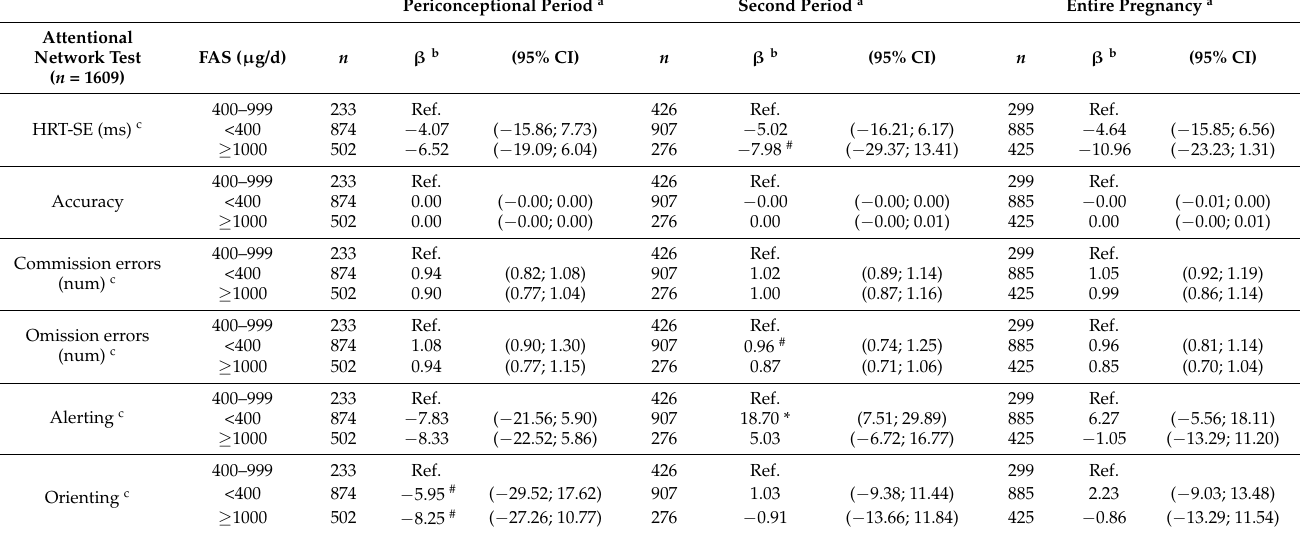
Table 2. Fully adjusted combined association between folic acid supplements (FAs) intake during pregnancy and attentional function in children aged 7–9 y of INMA cohort study, Spain, 2003–2008. Periconceptional Period a Second Period a Entire Pregnancy